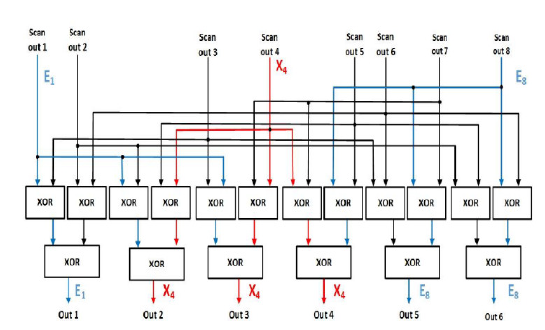
FIG. 3: X-COMPACTOR DESIGN WITH X-